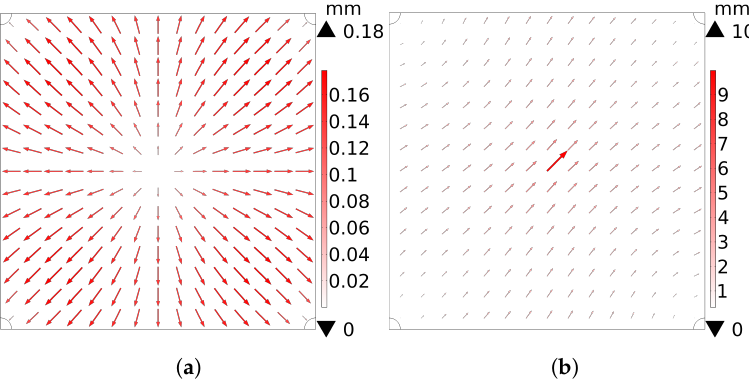
Figure 6. Deformation analysis of a 28 mm × 28 mm × 500 µ m PDMS film. The displacement of points on the elastic film from the view of an image sensor (components of a three-dimensional displacement on the focal plane), when ( a ) normal and ( b ) shear force are applied at the center. The four corners of this elastic film are fixed. The length and saturation of the red arrows are proportional to the magnitude of the displacement. The direction of each arrow reflects the direction of its displacement.